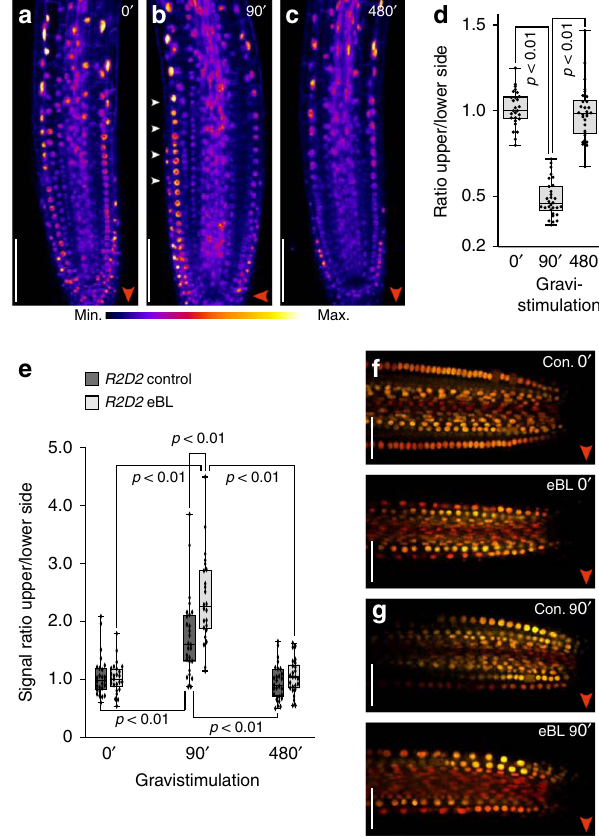
Fig. 7 Brassinolide and auxin responses in gravistimulated roots. a – c Heat map of 35S::BES1:GFP expression in root meristems after 0 ( a ), 90 ( b ) and 480 ( c ) min of gravistimulation. White arrowheads indicate asymmetric reporter expression after 90 min. d BES1:GFP signal ratios at the upper vs. lower side of gravistimulated roots. Signal intensities in 9 – 10 roots were determined for each dataset. e R2D2 signal ratios at the upper vs. lower side of gravistimulated root meristems, grown on PNS or pre- treated with 100 nM eBL. 24-27 roots of 6-day-old seedlings were analyzed for each dataset. f, g R2D2 expression and gradient formation in control roots and eBL-treated roots, after 0 ( f ) and 90 ( g ) minutes of gravistimulation. One-way ANOVA with post-hoc Tukey HSD tests were performed, to obtain p -values. Whiskers in box plots cover the entire range of outliers obtained in the datasets; gray boxes: fi rst and third quartiles; center line: median; dots: values obtained. Scale bars: a – c, f, g = 50 μ m. Red arrowheads: Direction of gravity vector. Source data are provided as Source Data fi